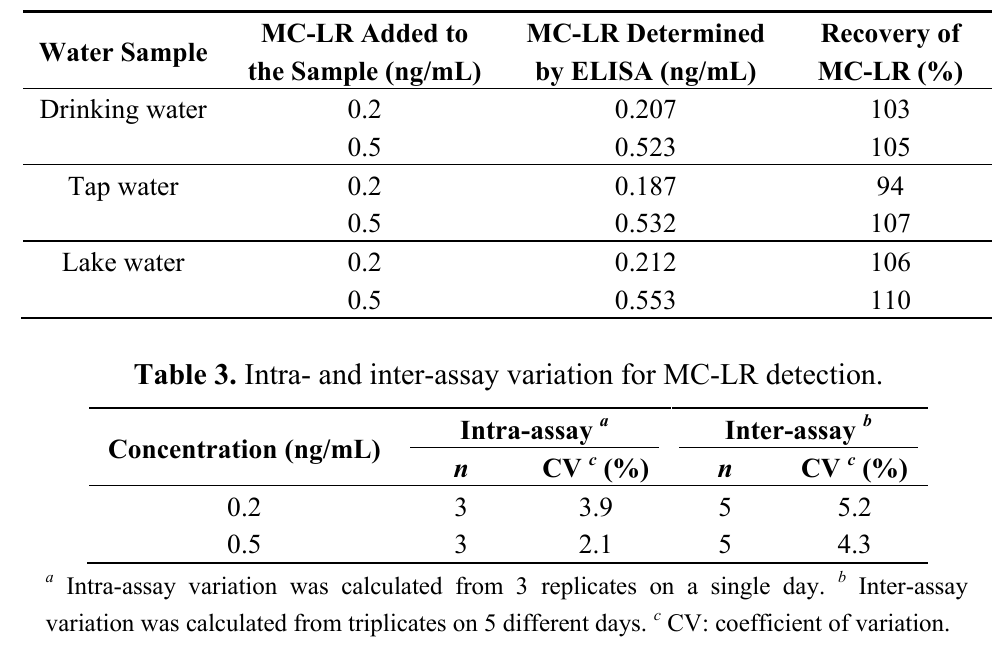
Table 2. MC-LR recovery values from spiked water sample by ELISA.